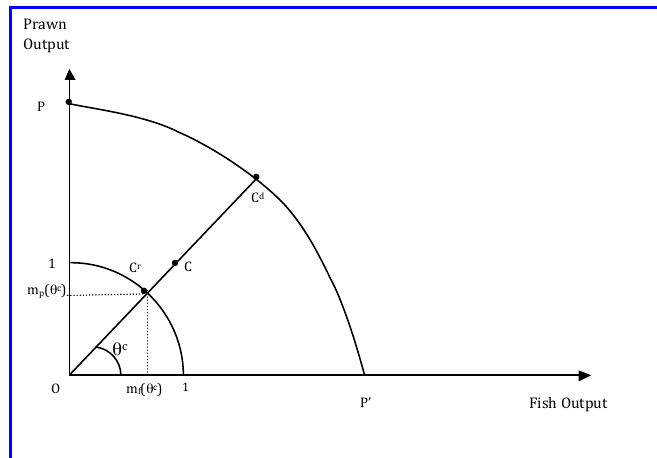
Figure 1. Graphical presentation of the ray production